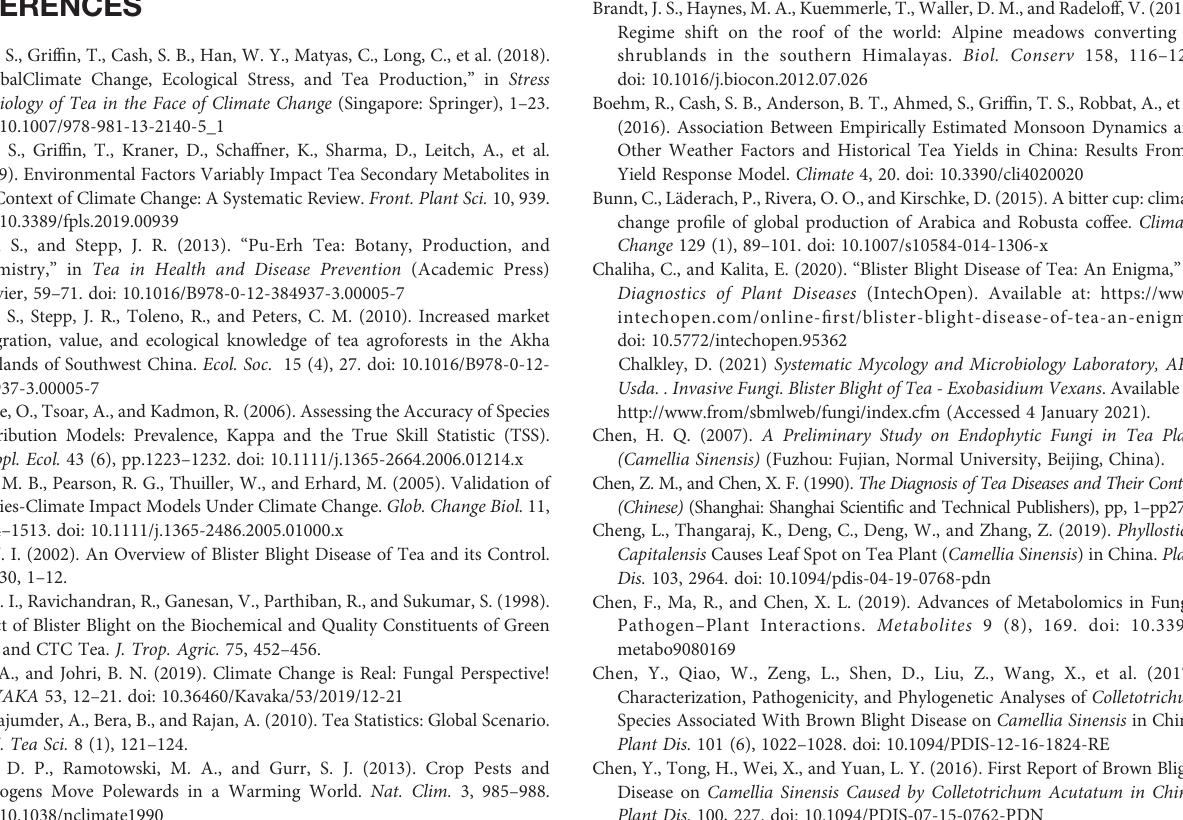
Supplementary Table 2 | Fungal diseases reported from Camellia sinensis, con fi rmed by morphology, genomics and pathogenicity (the bold type shows pathogens used in this study).